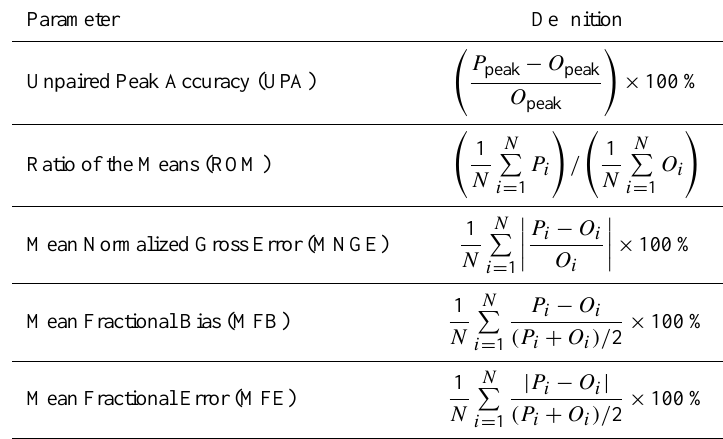
Table 2. Definition of statistical